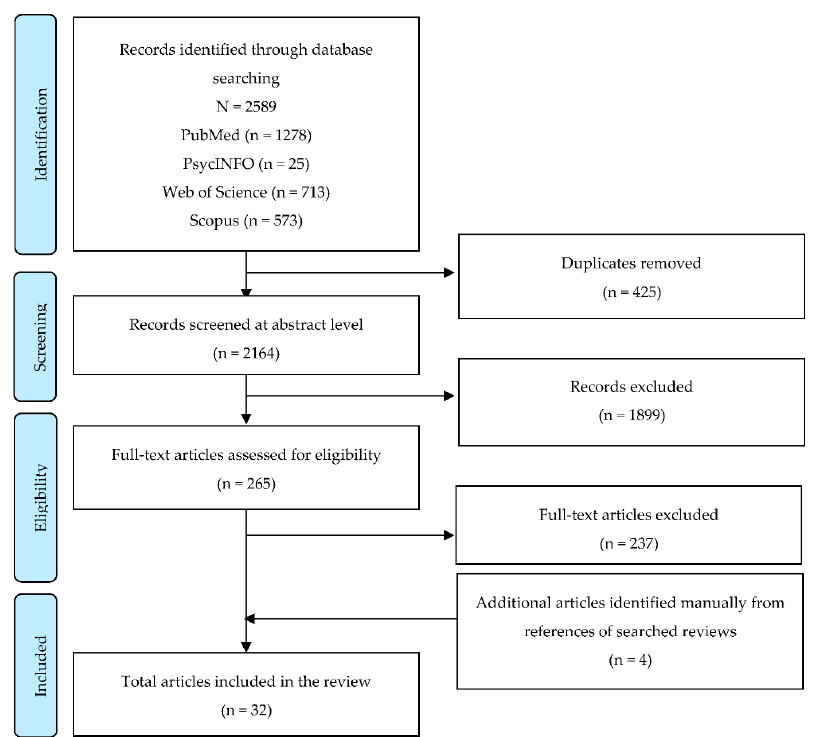
Figure 1. Flow diagram illustrating the selection process.